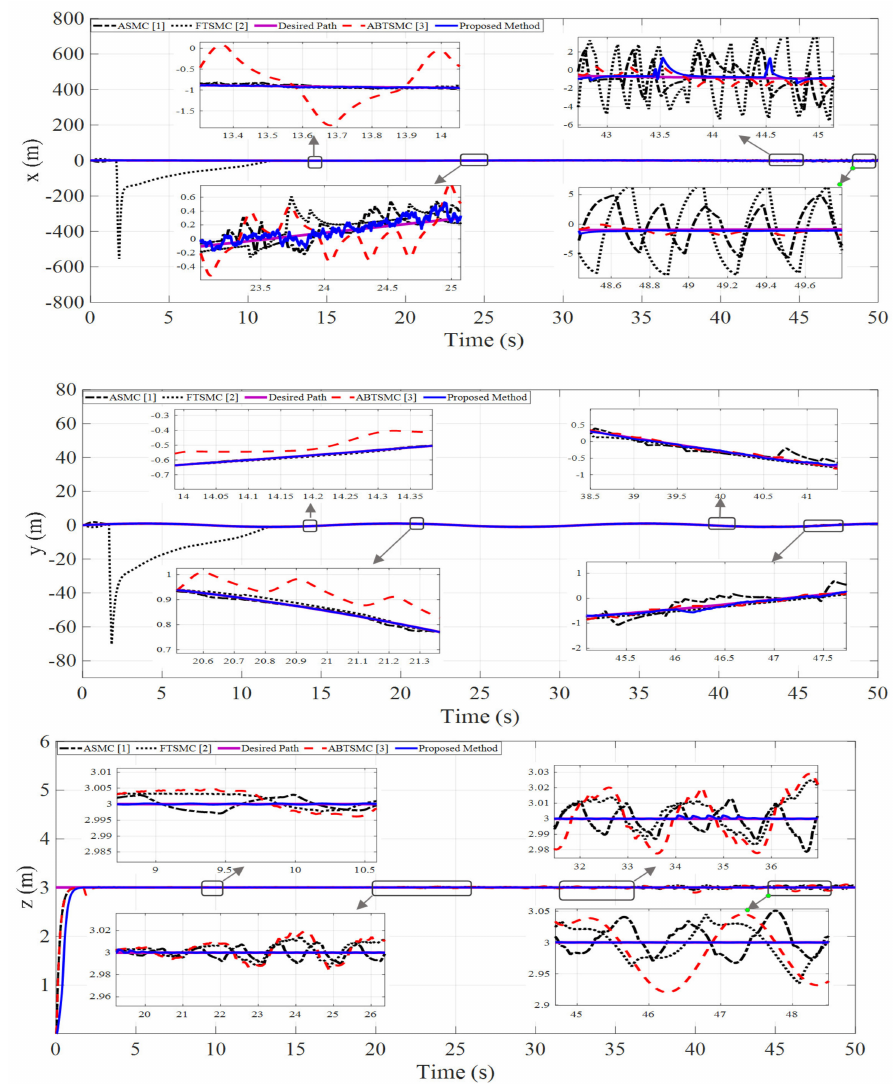
Figure 3. Quadrotor position under 40% sinusoidal fault to actuators 2 and